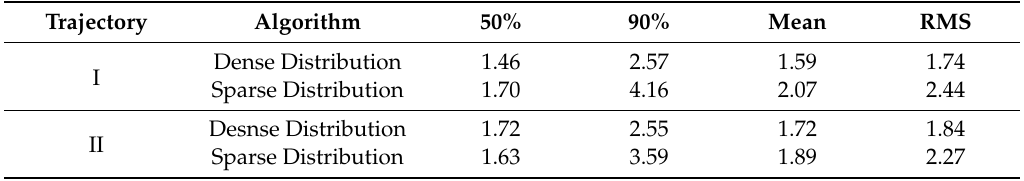
Table 3. Summary of localization errors of the two trajectories using the proposed algorithm with both dense and sparse distribution of BLE beacons